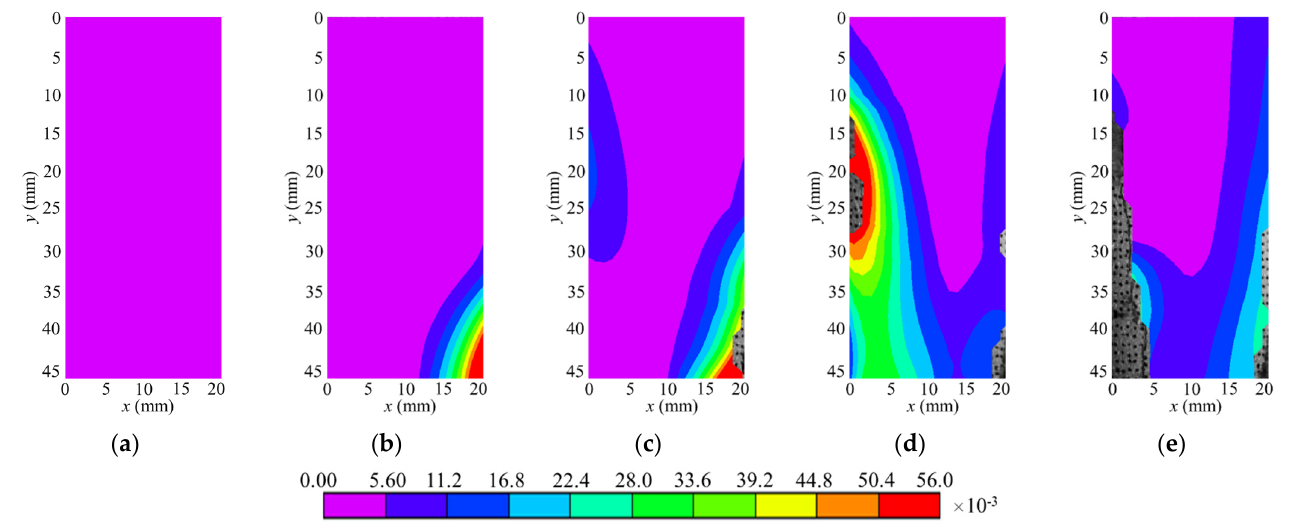
Figure 14. The principal strain fields corresponding to point ( a – e ) under different loading stages in Figure 13.